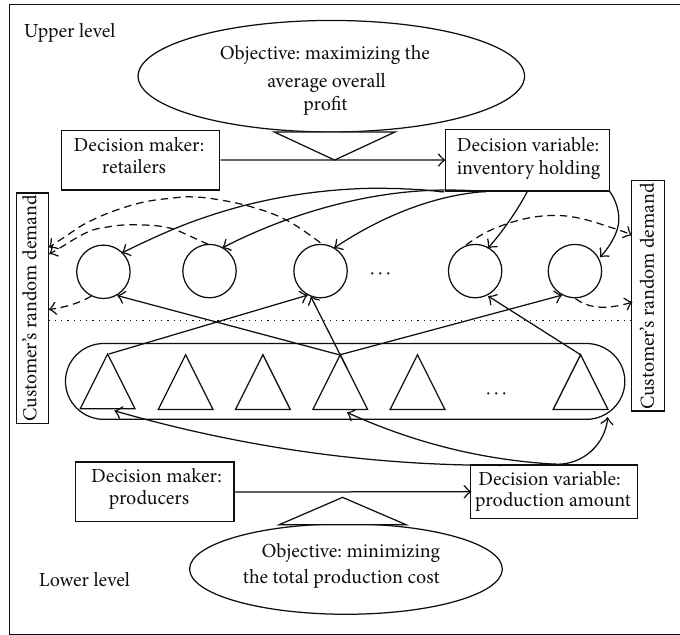
Figure 1: Structure of a production-inventory